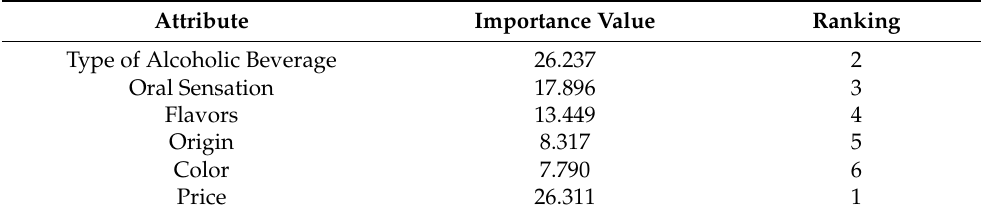
Table 5. Summary of Importance